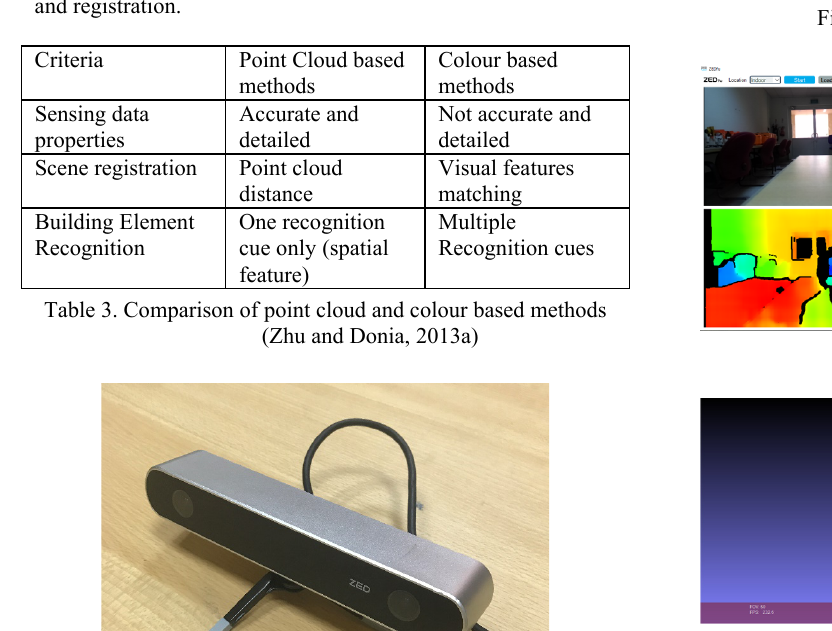
Figure 4. 3D Point Cloud cropping on MeshLab